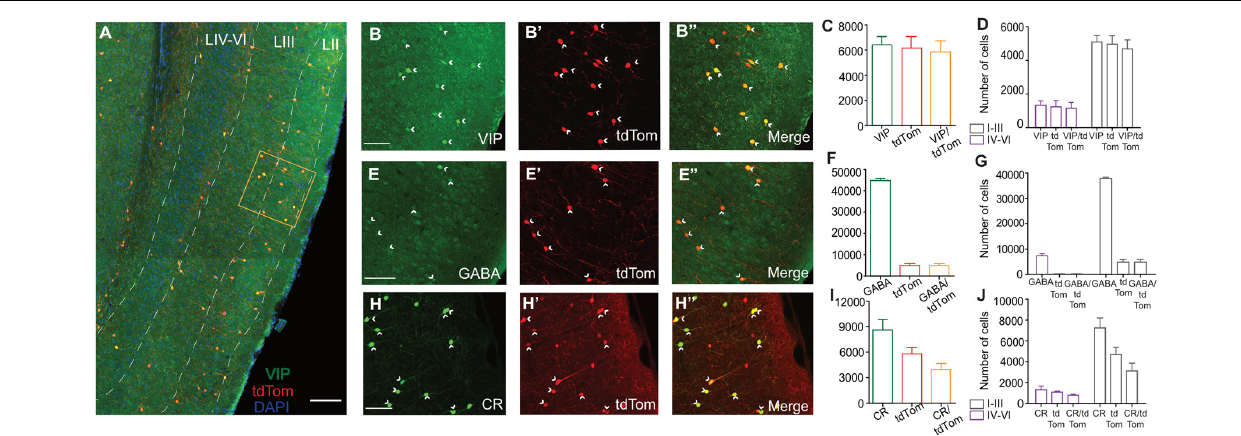
FIGURE 1 | Specificity of cre-driven fluorescence for Vasoactive Intestinal Peptide (VIP) in VIPcre/tdTom mice and presence of colocalization with other molecular markers. (A) Co-expression of VIP (green) and tdtom (red) in a sagittal section of the MEC at low magnification 10x. Layers of the MEC (white dashed lines) marked using DAPI as reference. High magnification of framed area (orange box) is shown in (B–B”) . (B–H”) 20x maximum projection intensities of a 40- µ m thick section of superficial MEC treated with IHC using α VIP AB (B–B”) , α GABA AB (E–E”) , and α CR AB (H–H”) . Fluorescence of cre-driven tdTomato expression is shown in red (B’–H’) and colocalization of the two channels is shown in (B”–H”) . The presence of colocalization is indicated by yellow cell bodies and white arrowheads. Graphs depicting the total number of cells present in the MEC (C–I) and distribution of somas in different layers of the MEC (D–J) for α VIP, α GABA , and α CR respectively are shown here. Percentages displayed for colocalization bar show the number of tdTom positive cell bodies which colocalize with the IHC marker. For IHCs performed for α VIP and α CR, n = 3 animals and for IHC performed against α GABA, n = 2 animals. Each bar represents a mean and error bars represent SEM. For panels (B–H”) scale bars are 250 µ m. The scale bar in (A) is 500 µ